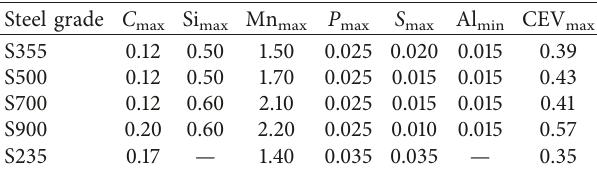
Figure 2: Test cell for permeation experiments, with compartment with pickling solution on the right side and 0.2M NaOH on the left side. Table 1: Chemical compositions of steels used in experiments.